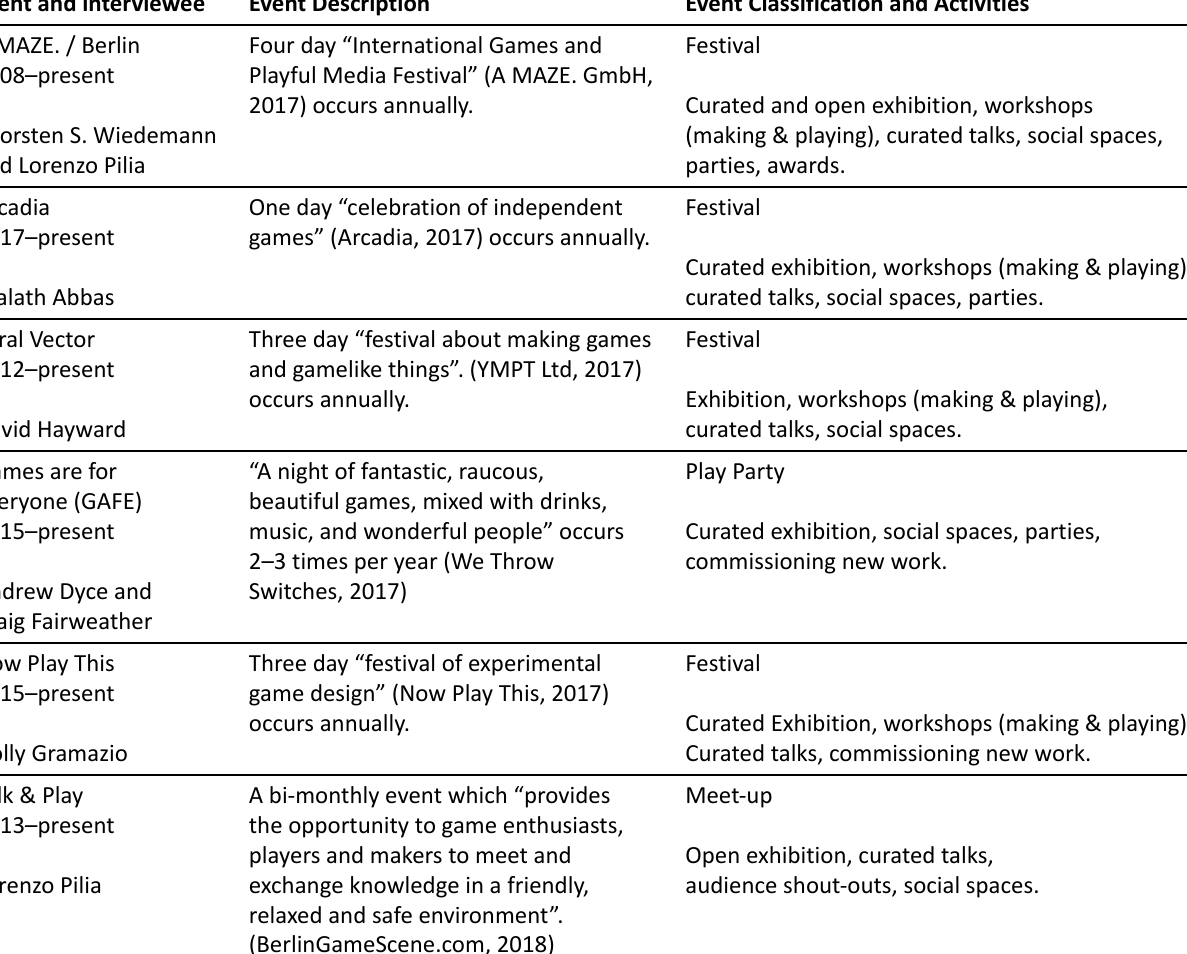
Table 1. Overview of the events studied within this research including interviewee names, event descriptions, activity types, and attendee